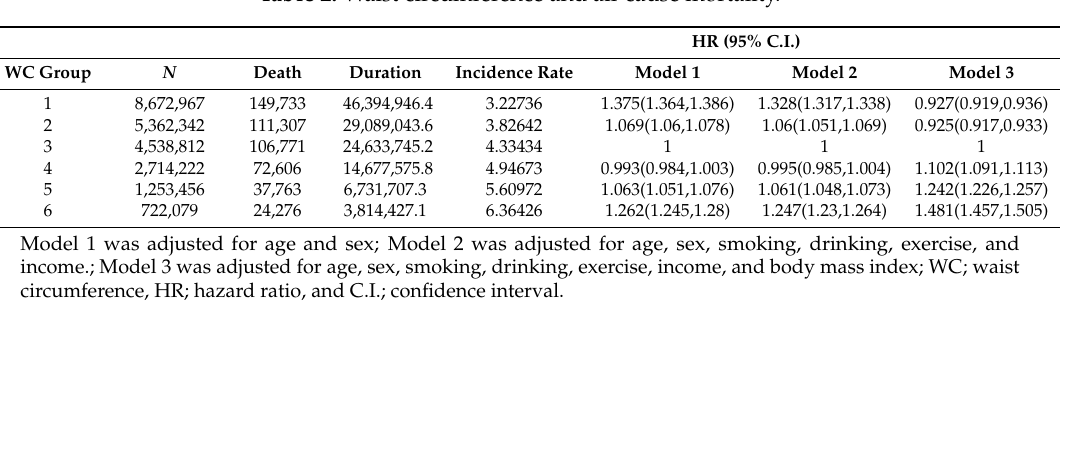
Table 2. Waist circumference and all-cause mortality.